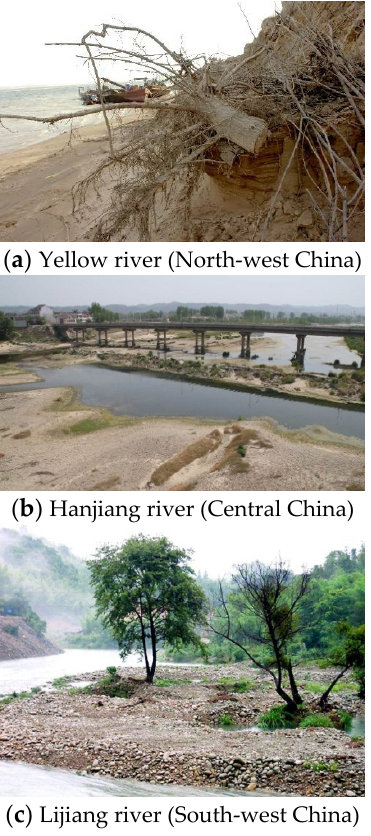
Figure 1. Wide-spreading disastrous cases due to river sand excavation in China.